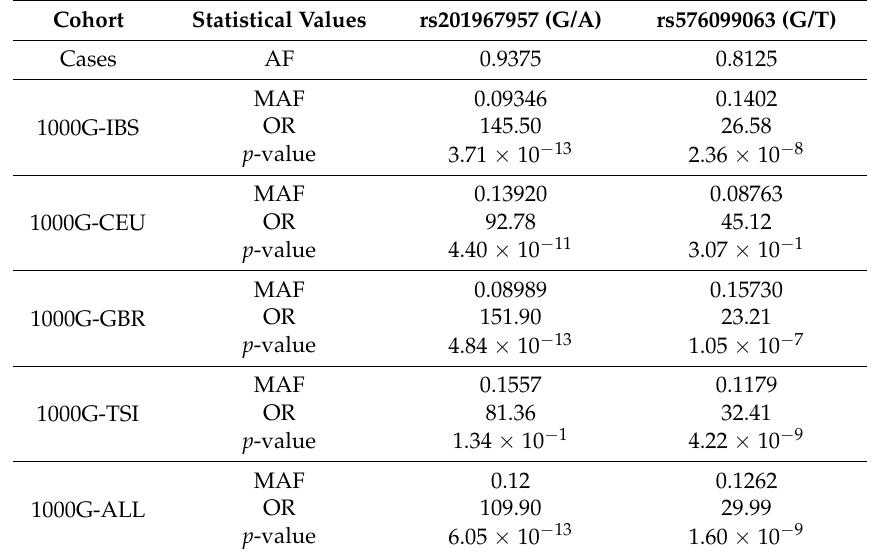
Table 3. Association test of the best two single nucleotide polymorphism (SNP) candidates: rs201967957 (G/A) located in gene MEIS1 (chromosome 2) and rs576099063 (G/T) located in gene TSPAN15 (chromosome 10). The table shows results for comparisons of cases versus different control groups, namely, 1000G-IBS, 1000G-GBR, 1000G-TSI, all these 1000G controls merged in a single